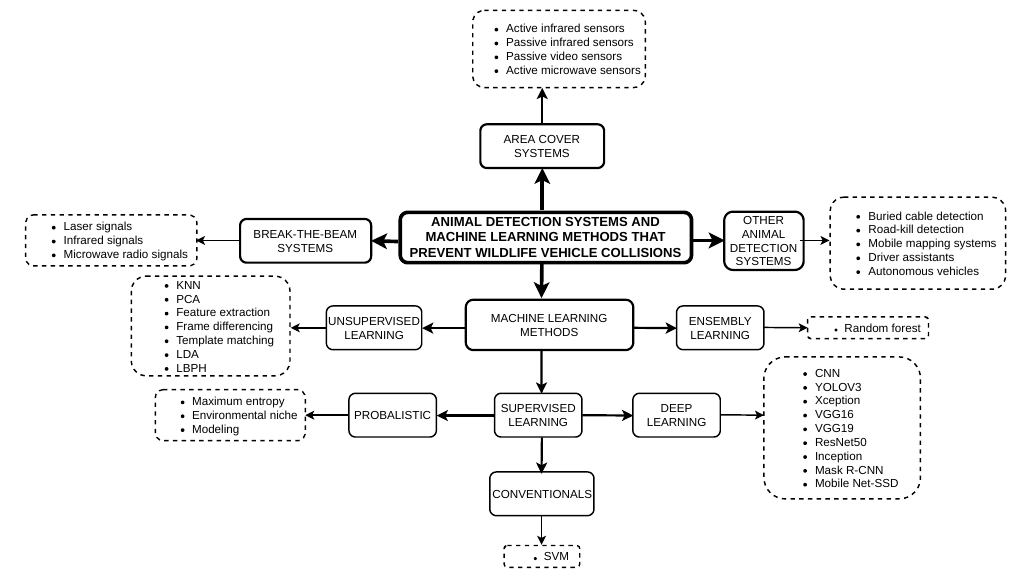
Figure 6. Summary of existing intelligent systems and/or machine learning methods that pre- vent